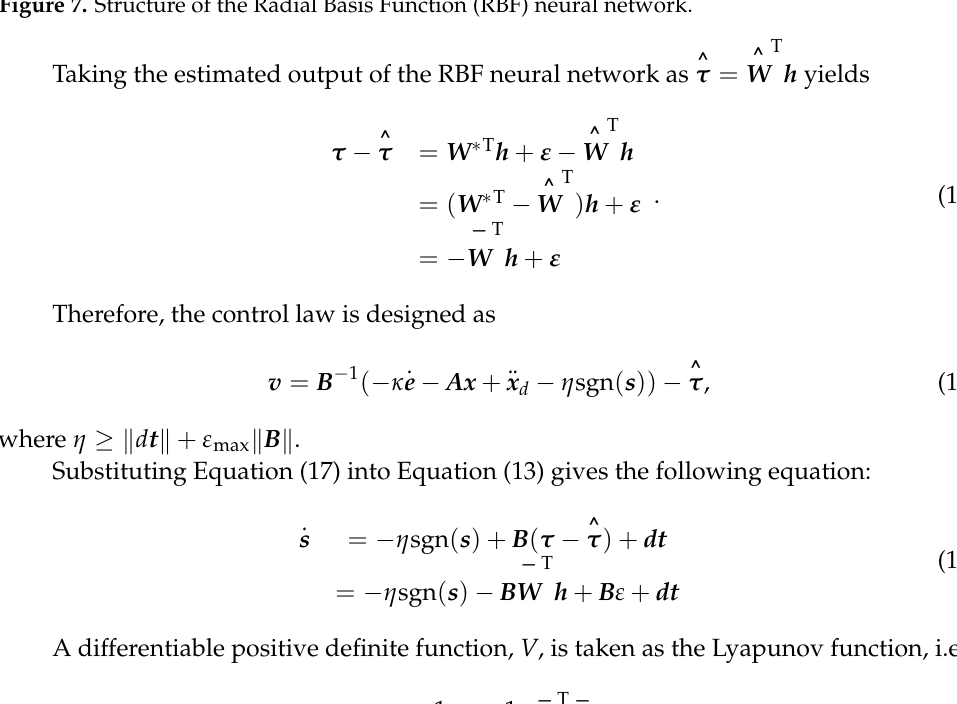
Figure 7. Structure of the Radial Basis Function (RBF) neural